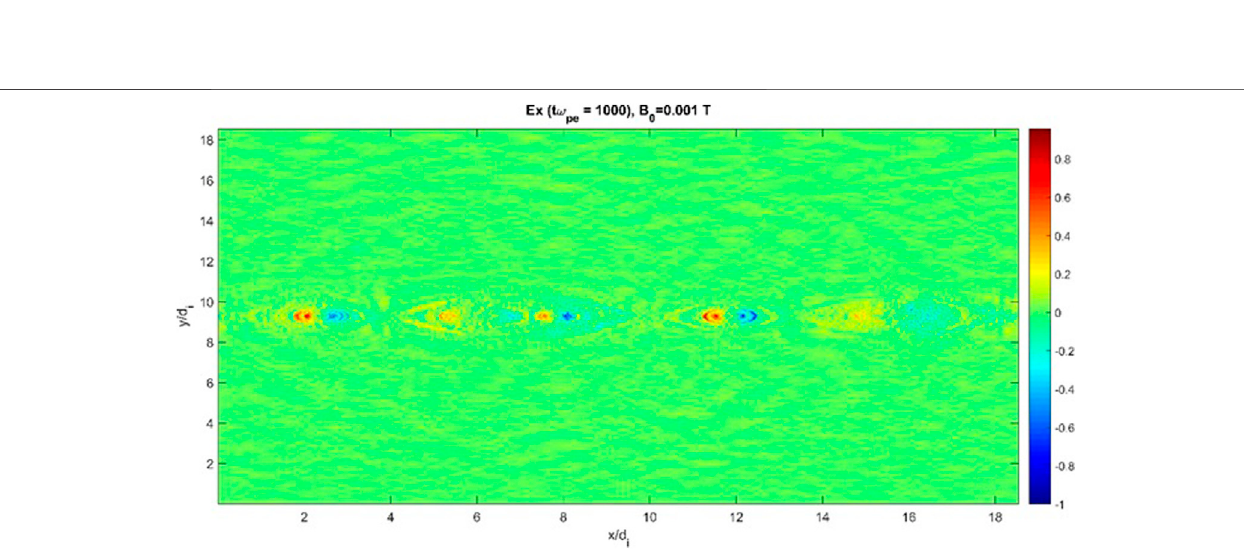
Frontiers in Astronomy and Space Sciences |